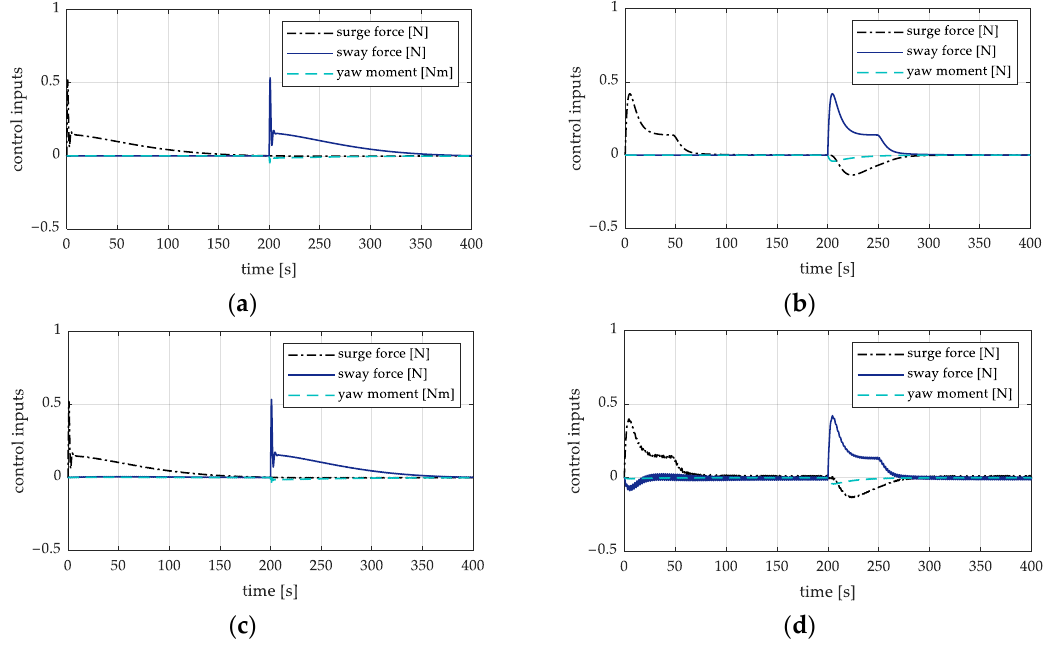
Figure 7. The control inputs of the barge ship. ( a ) Conveyed with the H ∞ controller; ( b ) conveyed with our sliding mode controller; ( c ) conveyed with the H ∞ controller under disturbance; ( d ) conveyed with our sliding mode controller under disturbance.